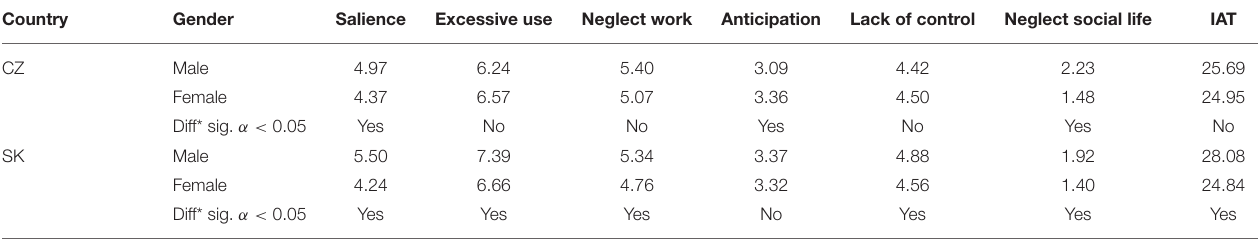
TABLE 3 | Mean values of the IAT and its subscales in the classification by gender. Country Gender Salience Excessive use Neglect work Anticipation Lack of control Neglect social life